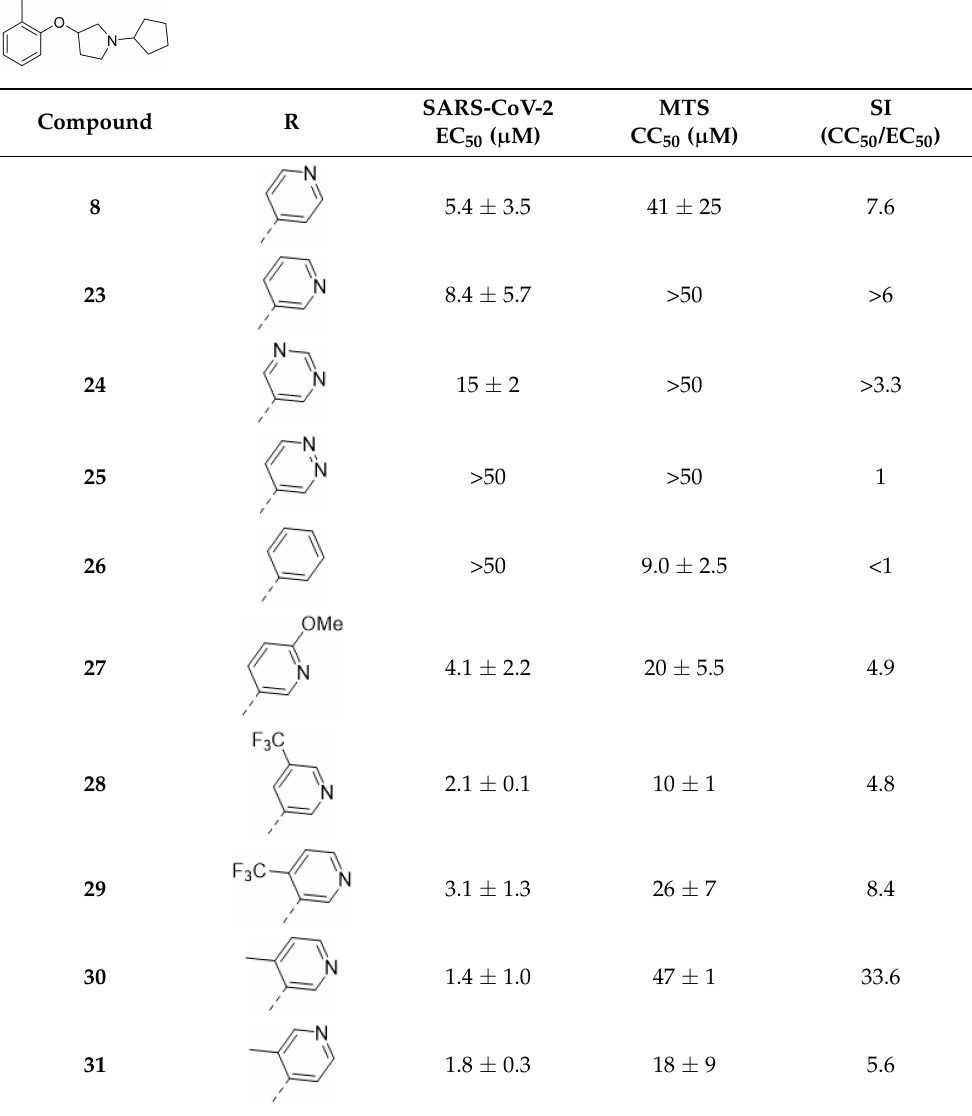
Table 3. Antiviral activity and cytotoxicity of compounds 8 and 23 – 31